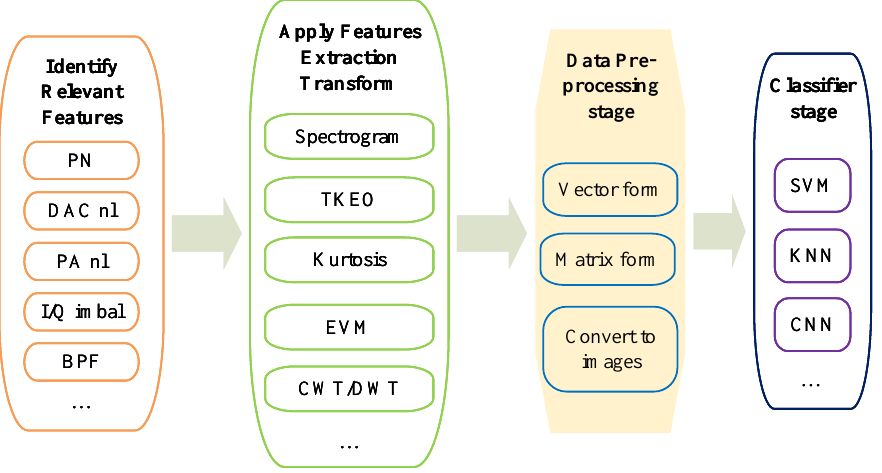
Figure 3. The proposed methodology for an RFF algorithm applied to GNSS pre-correlation sampled